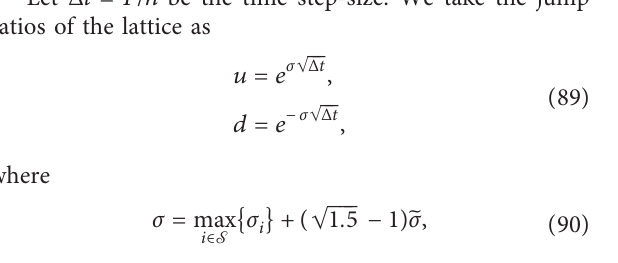
Figure 1: Sample path of Markov chain and stock price with (A.) α � 1, and early exercise boundary when η ≤ r ≤ μ S 0